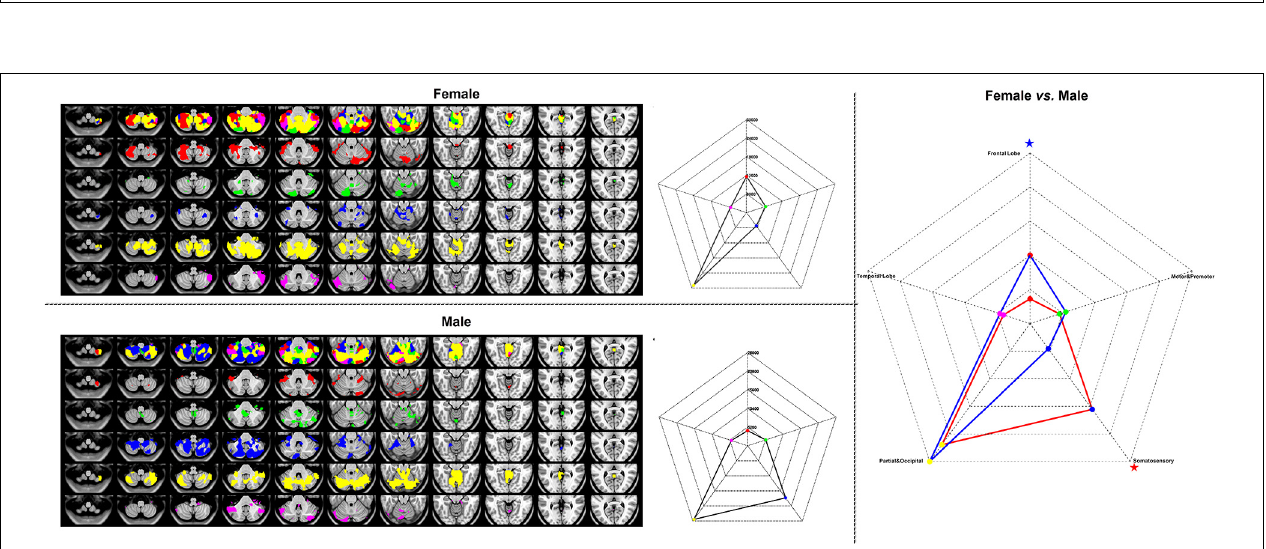
FIGURE 6 | The results of modulation mode with X (seed)-to-Y (Brain/Target ROI). Panels (A , D , G) were the results of seed-to-brain connectivity of the GMV. Panels (B , E , H) were the results of seed-to-brain connectivity of thickness. Panels (C , F , I) were the results of ROI-wise connectivity of the GMV with the AAL template. All results were set at the threshold of p < 0.05 uncorrected. The ROI-wise connectivity contained the seed-to-Target and Target-to-seed effects.